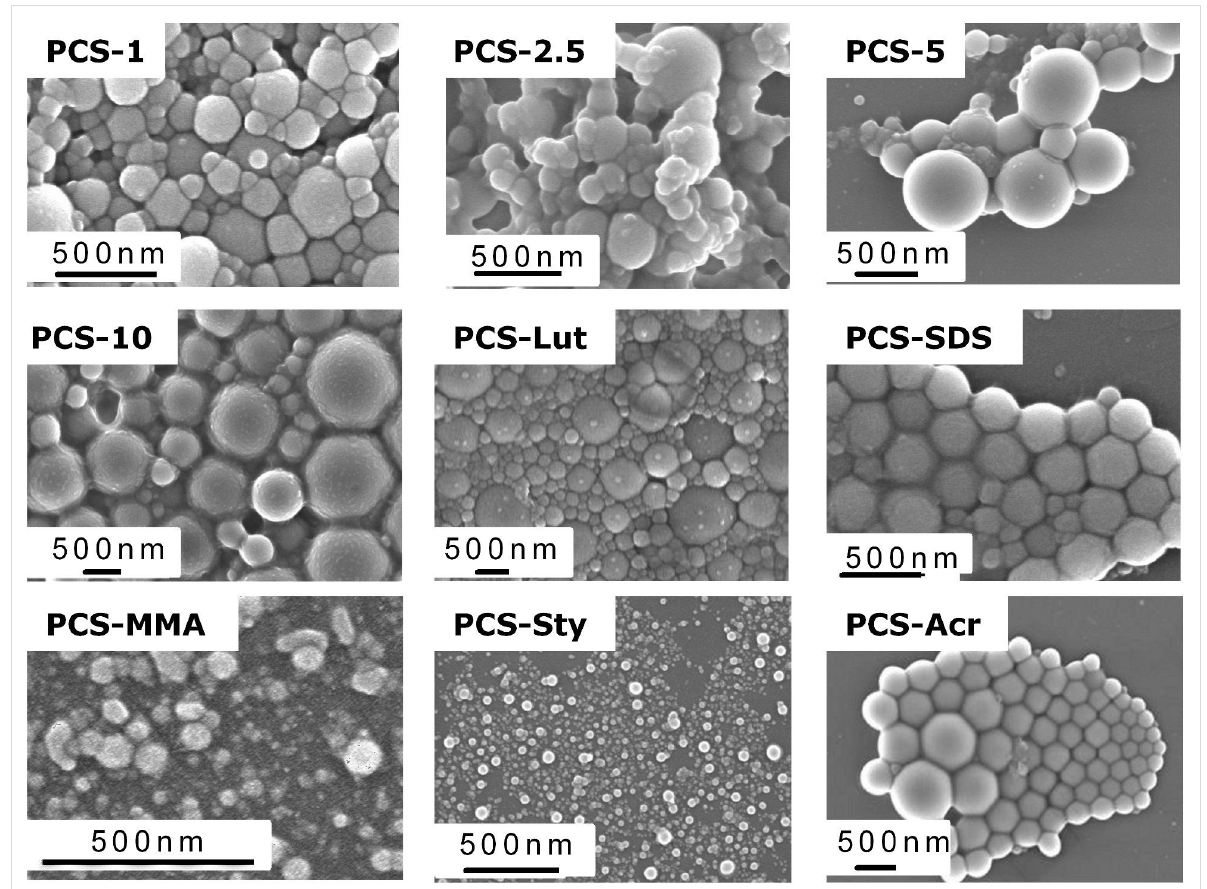
Figure 3: Scanning electron micrographs of PCS spheres synthesized with different amounts of CTAB (PCS-1 - PCS-10), different surfactants (PCS- Lut, PCS-SDS) and comonomers (PCS-MMA, PCS-Sty).